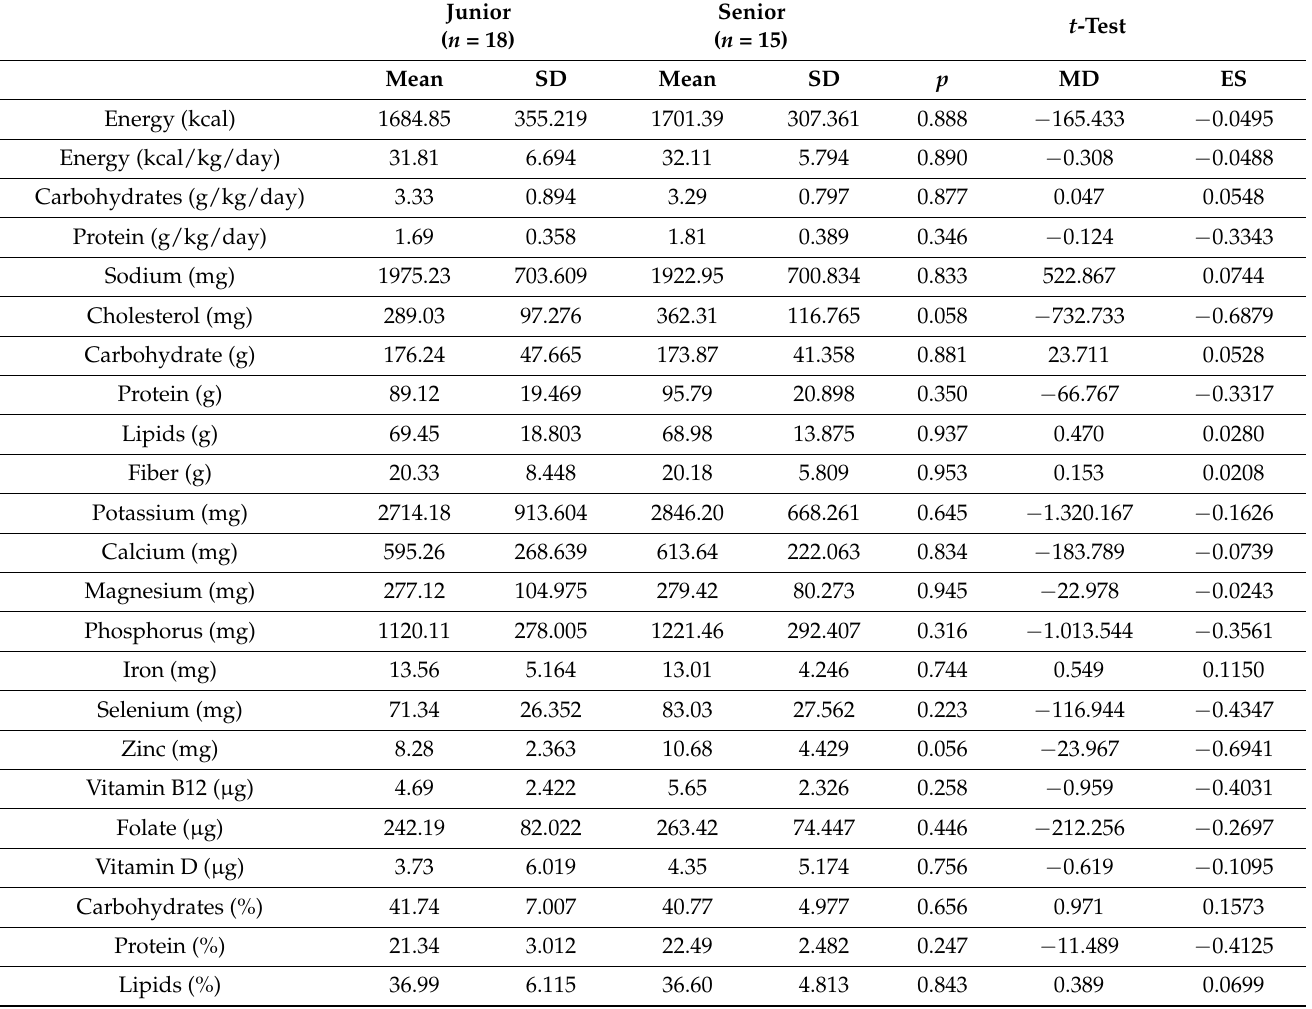
Table 1. Quantitative analysis of the players’ diets.